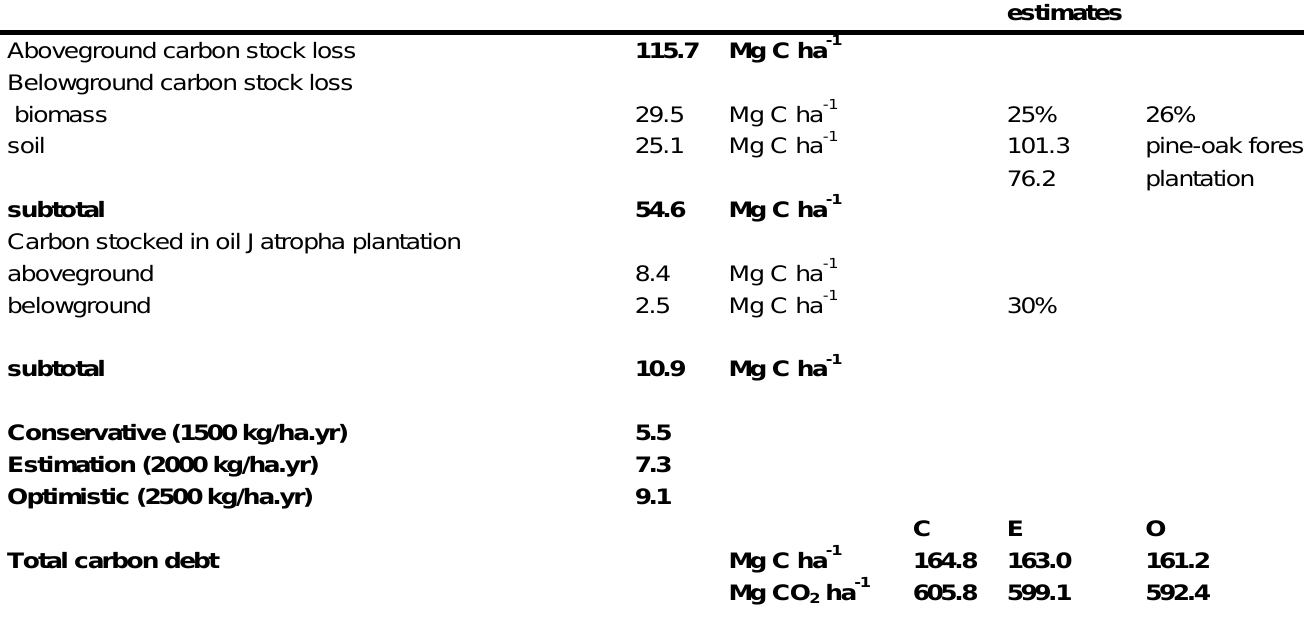
Table A4.2. Carbon debt calculation of Michoacan, Mexico case Carbon debt due to conversion of secondary forest